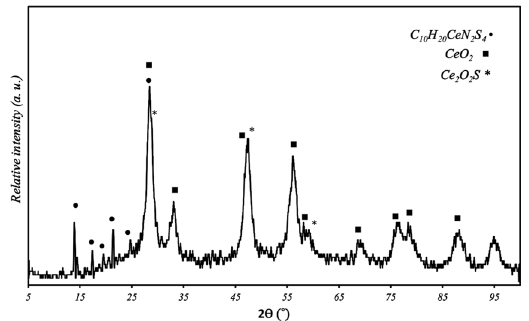
Figure 1. The X-ray diffraction pattern of synthesized Ce-DEDTC pigment.